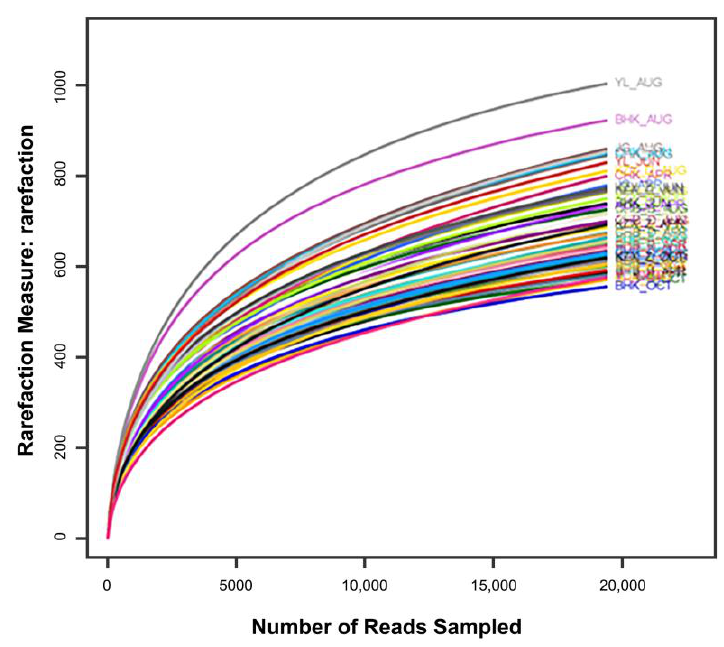
Figure 2. Rarefaction curves for Operational taxonomy units (OTUs) that were calculated using MOTHUR with reads normalized to 19,380 for each sample.